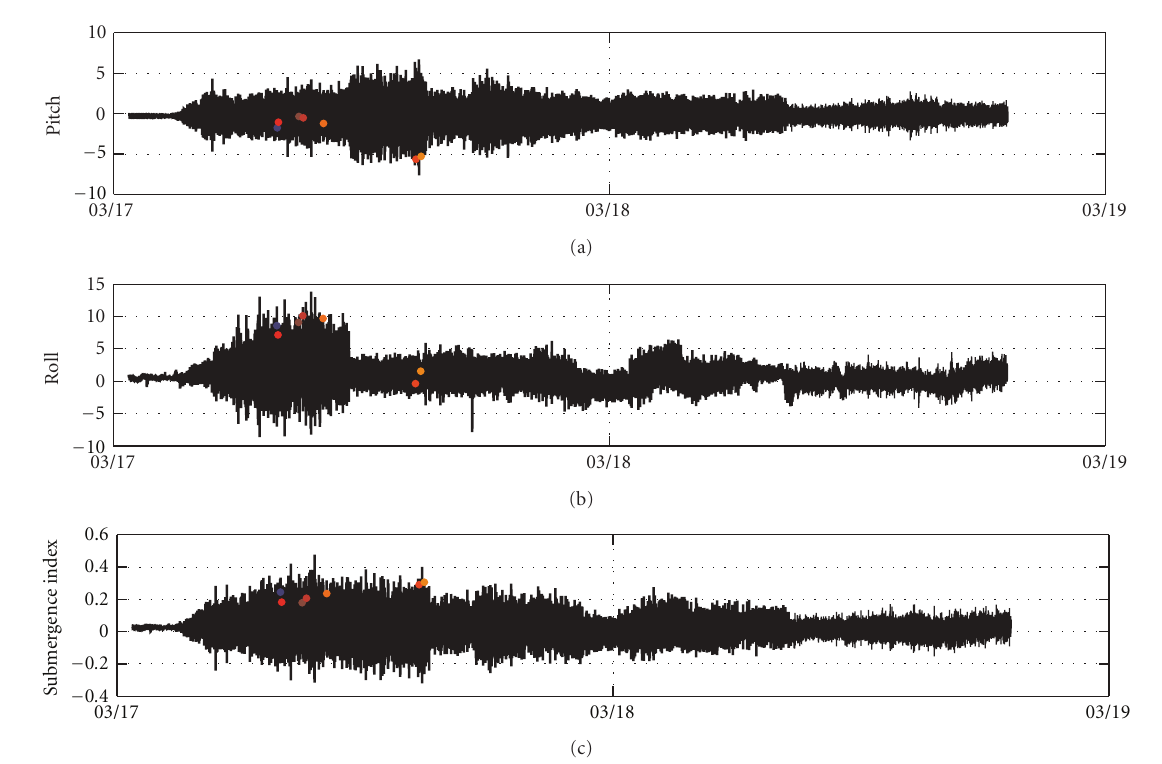
Figure 18: Ship motions during the analyzed